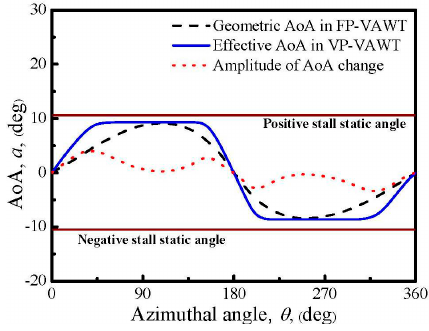
Figure 6. Curve of pitch angle in new approach.